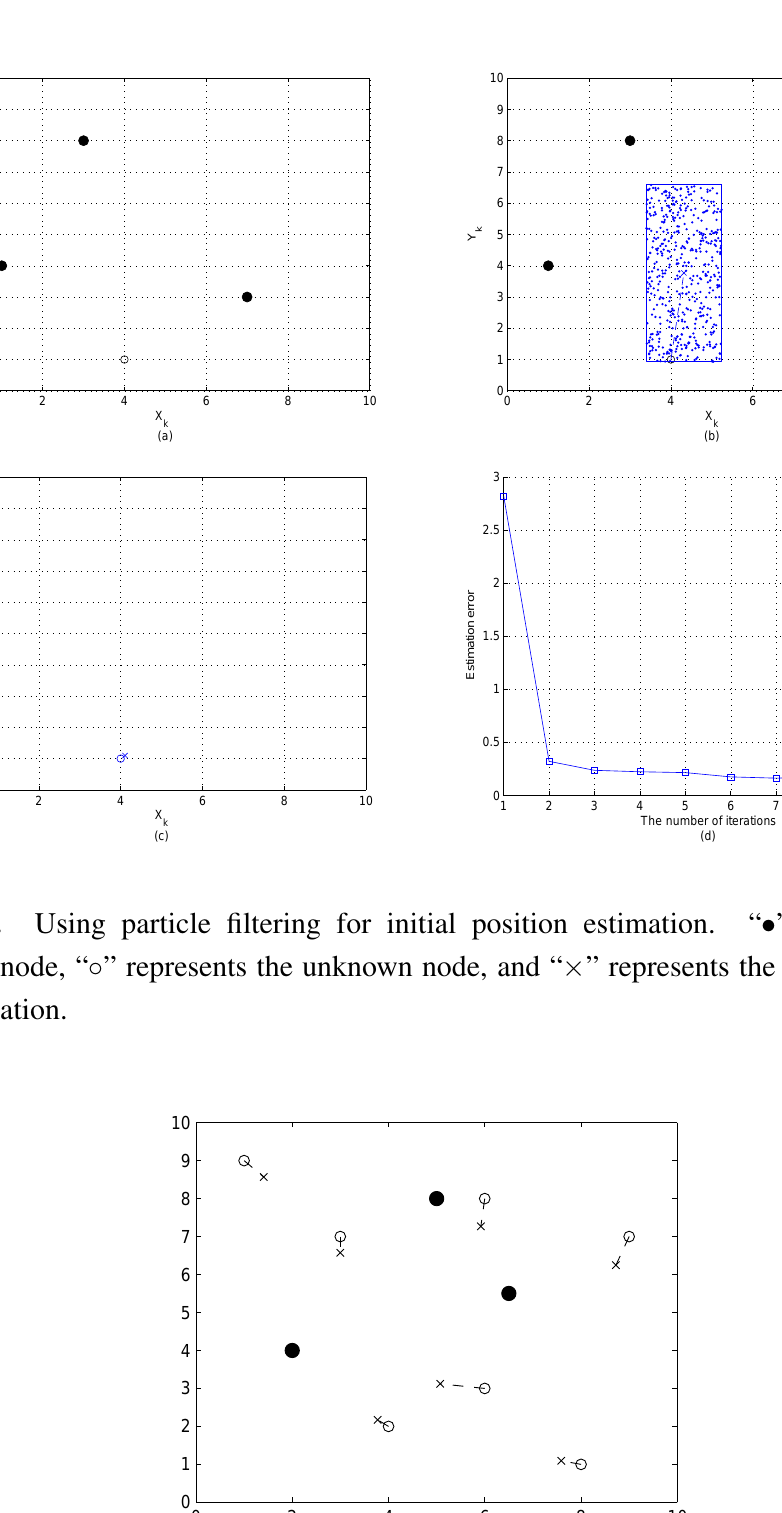
Figure 7. (a)-(c) are the procedures of initial position estimation by using particle filter method with bounding box algorithm; (d) shows the estimation error of the initial position estimate.